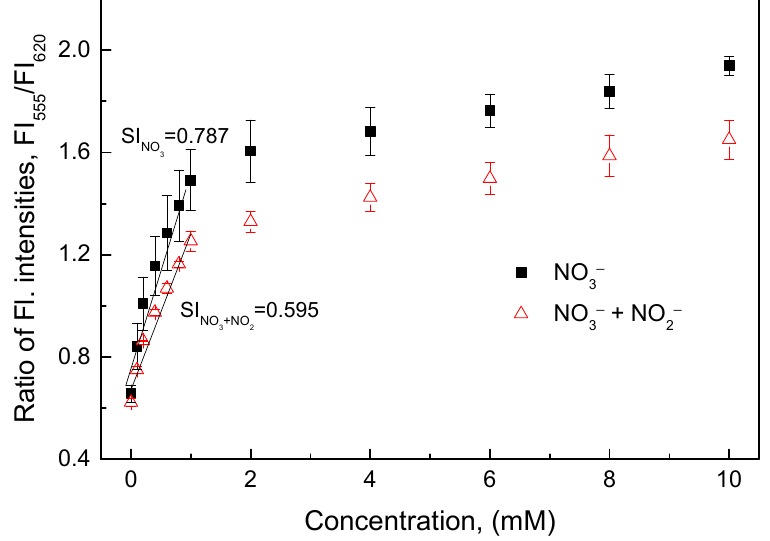
Figure 6. Response of the O17-HT-EC membrane when exposed to nitrate solutions containing nitrite with the same nitrate concentrations.